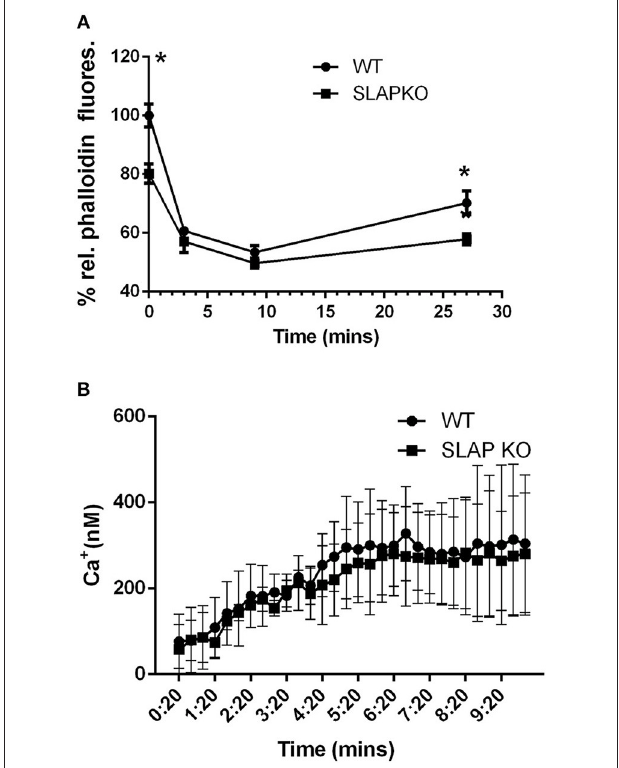
FIGURE 4 | F-actin levels and calcium mobilization in SLAP KO BMMCs. (A) BMMCs from WT and SLAP KO genotype were sensitized with Anti-DNP IgE and stimulated with DNP-HSA (20ng/ml) for indicated times at 37 ◦ C. Line graph showing the relative phalloidin fluorescence at indicated times post-stimulation with DNP-HSA (20ng/ml) in WT and SLAPKO BMMCs where the median fluorescence intensities (MFI) values at all timepoints were shown as a % of MFI values of WT at 0min timepoint. Data shown are the means ± SD values of one representative experiment done in triplicate, out of total three independent experiments ( n = 3). A significant difference was observed between genotypes (Student’s t -test; * P < 0.05). (B) WT and SLAP